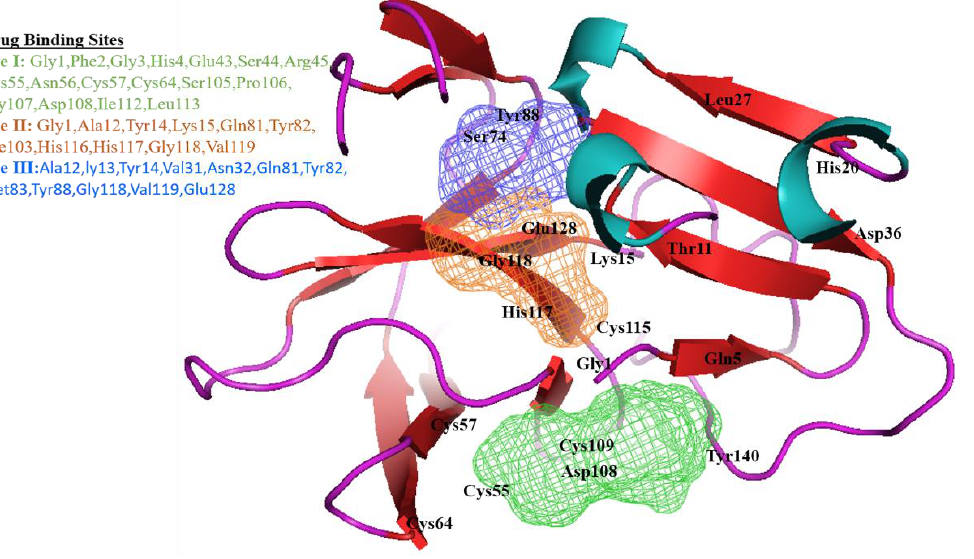
Figure 3. Representation of poliovirus 2A pr ° model along with binding site predictions. Ligand binding pockets were annotated by FTSite [32]. First binding site is in green color, while second and third are in orange and blue, respectively.